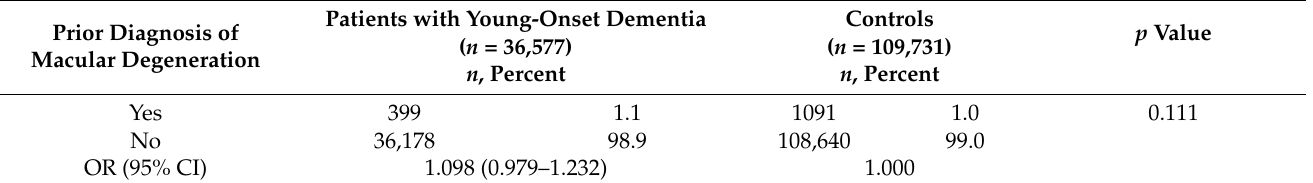
Table 2. Prevalence, crude odds ratios (ORs), and 95% confidence intervals (CIs) for prior age-related macular degeneration among patients with young-onset dementia vs.